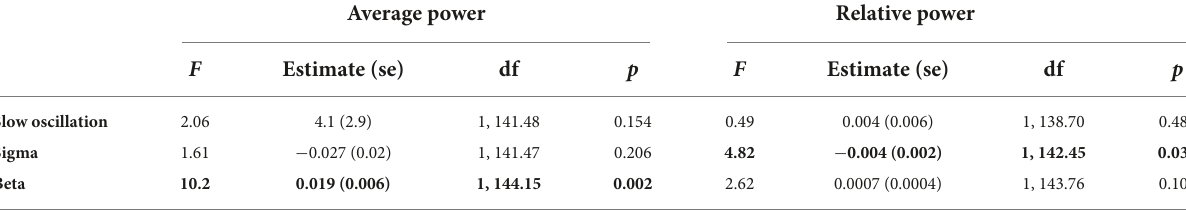
TABLE 4 Sham to CPAP cross-over within subjects change effects for spectral variables from the mixed